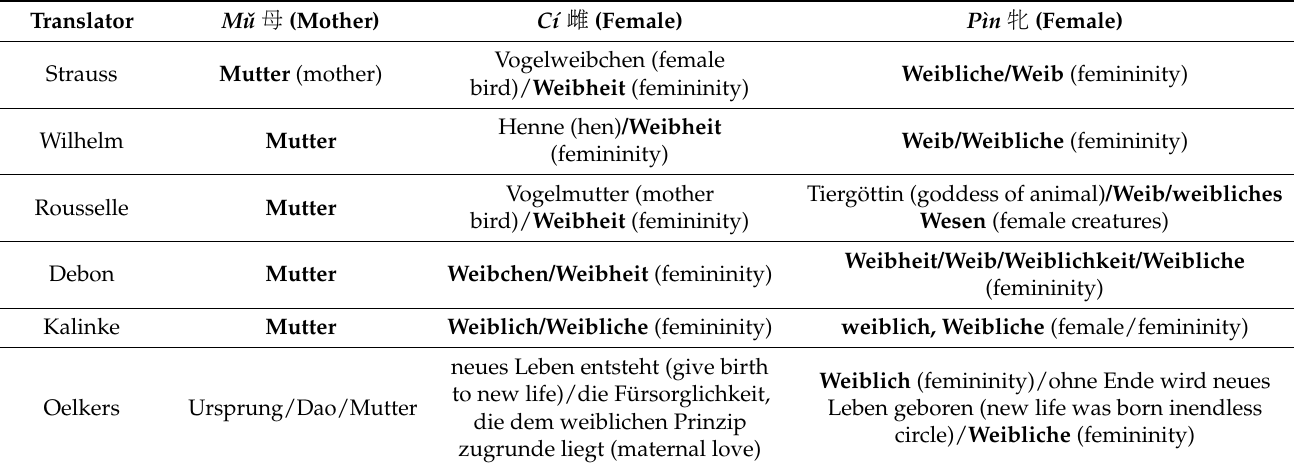
Table 2. Corresponding expressions of [Mˇu] in the German translations of the D à o D é J¯ıng .